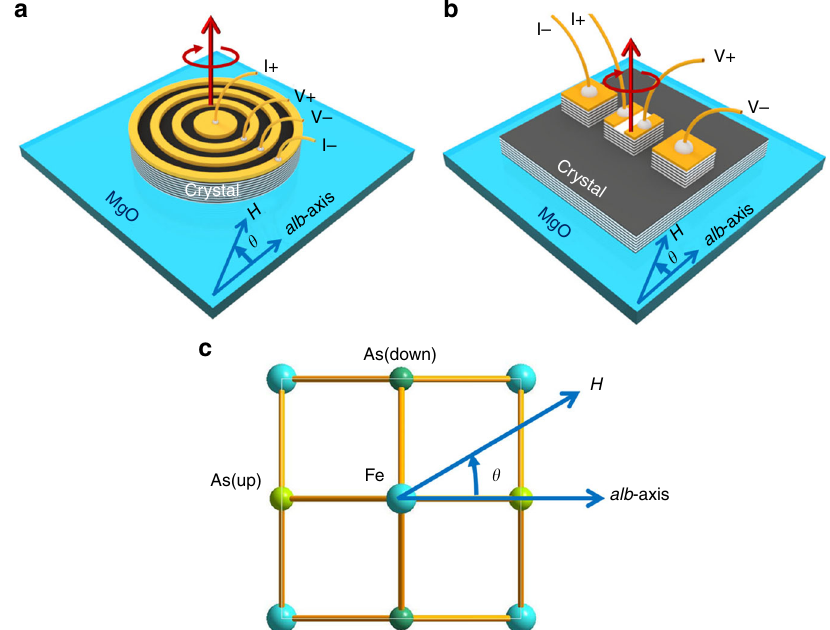
Fig. 1 Schematic image of the sample geometry. a Diagram of the Corbino-shape device for angular-dependent IMR ρ ab measurements. The electric current is lead to fl ow radially from the center to the outermost electrode, where the outermost electrode was in diameter of 80 μ m and the detailed sample geometry is given in Supplementary Fig. 2. The magnetic fi eld was applied to the ab -plane with an angular error of less than ± 1°. The angle was set to zero ( θ = 0) when the fi eld was parallel to one of a ( b )-axis. Then the sample was rotated within the ab -plane to tune θ between H and the a ( b )-axis. b Diagram of the mesa device for angular-dependent IMR ρ c measurements, where the thickness of the mesa was 1.5 μ m (see sample geometry in Supplementary Fig. 4). The magnetic fi eld was applied within the ab -plane. c Schematic image of the rotating crystal to adjust the angle θ between H and the a ( b )-axis